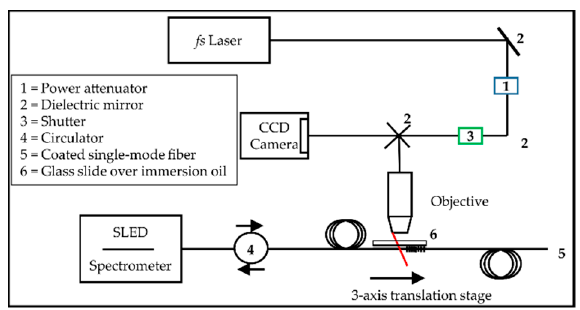
Figure 1. Experimental setup for fiber Bragg gratings (FBG) writing using ultrafast-laser-inscription, according to [23].